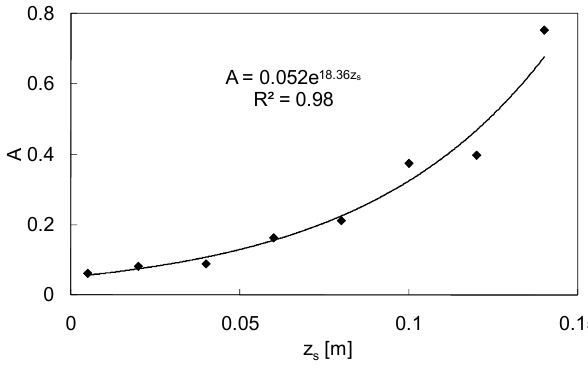
and A for d = 0.25 × 10 –3 m. s 50